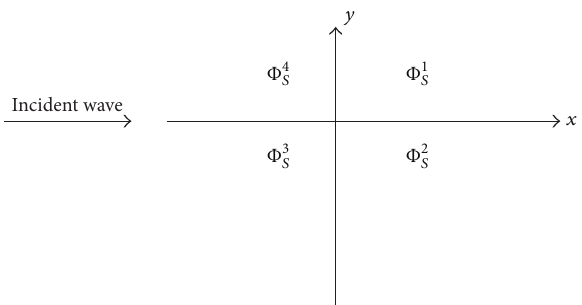
performed for 𝑇 = 10 , 𝑉 = 2 and are compared with corresponding results obtained from Newman. The values are shown in Figures 5 and 6. Obviously, the